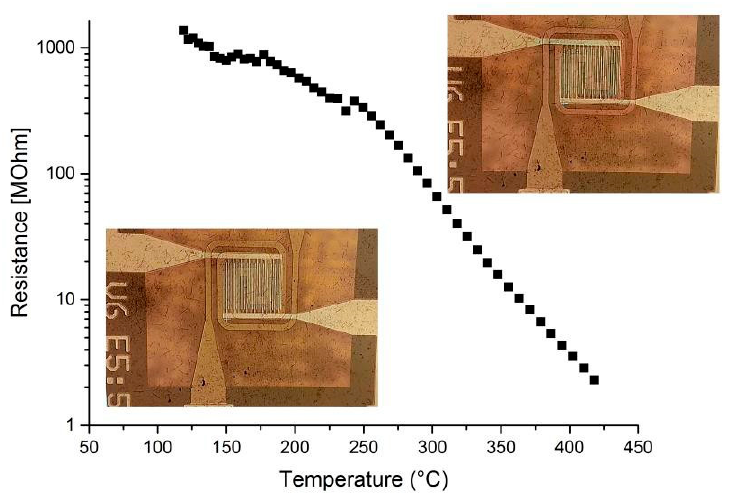
Figure 4. 2-point measurement of membrane-based gas sensor structure with transfer printed SnO 2 nanowires on top of the